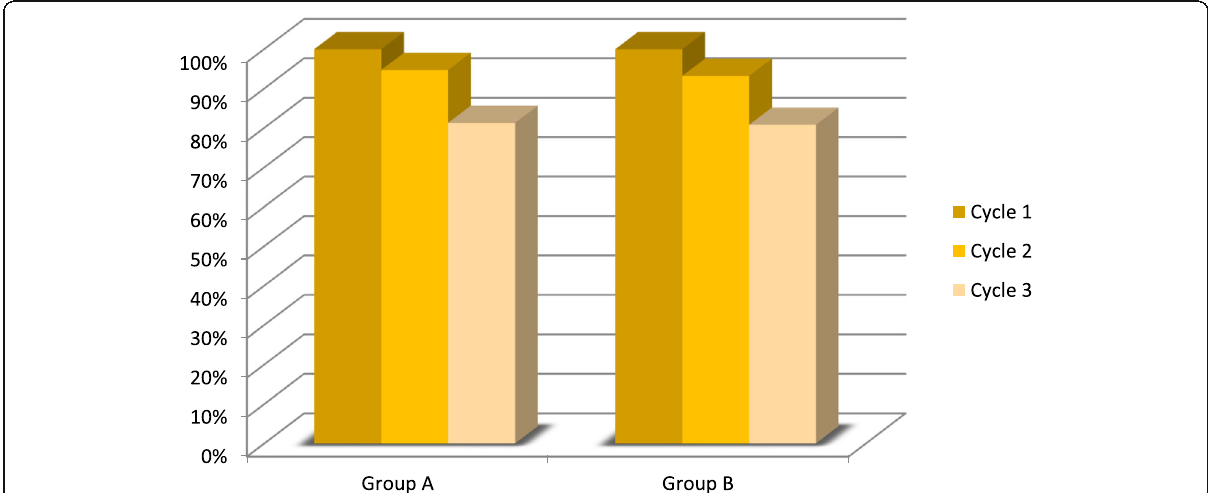
Fig. 3 Number of stimulated cycles during the study